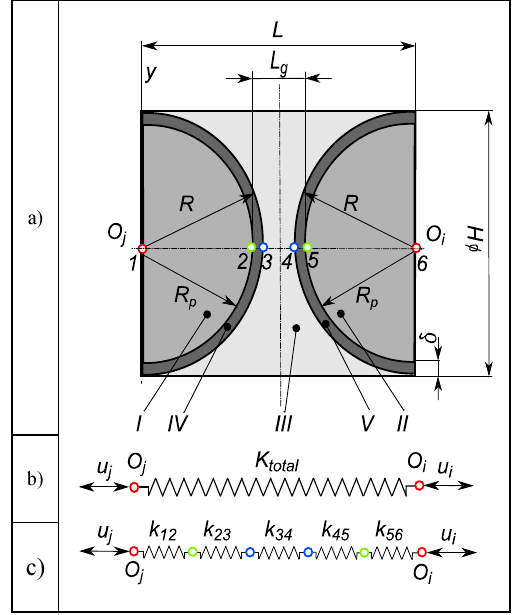
Fig. 3. Normal interaction of two equal particles with the film layer through the weaker interface: a) general geometry; b) a system of sequentially connected springs; c) the total spring equivalent to the system of the springs; I and II are particles, III is matrix, IV and V are the matrix film connected springs, stiffness of which k 12 , k 56 are denoted by numbers of connecting points as shown in Figure